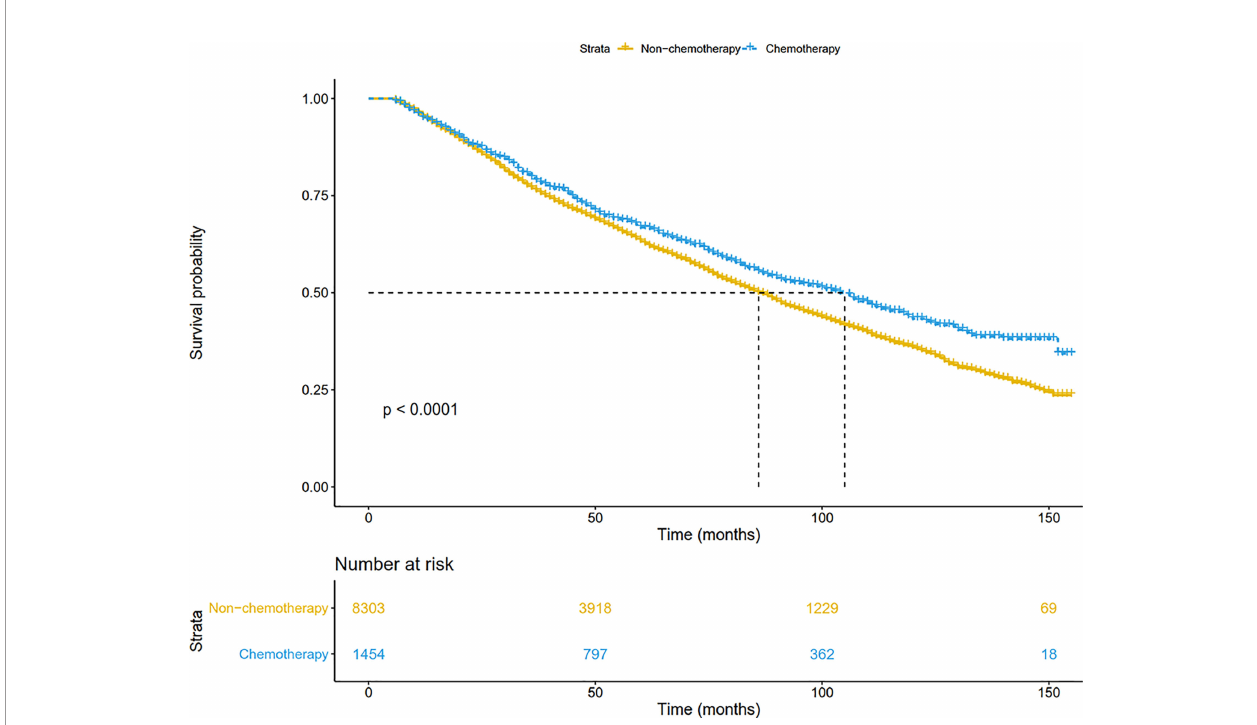
FIGURE 2 | Overall survival comparison by treatment arm for stage IB NSCLC patients in the SEER database cohort.